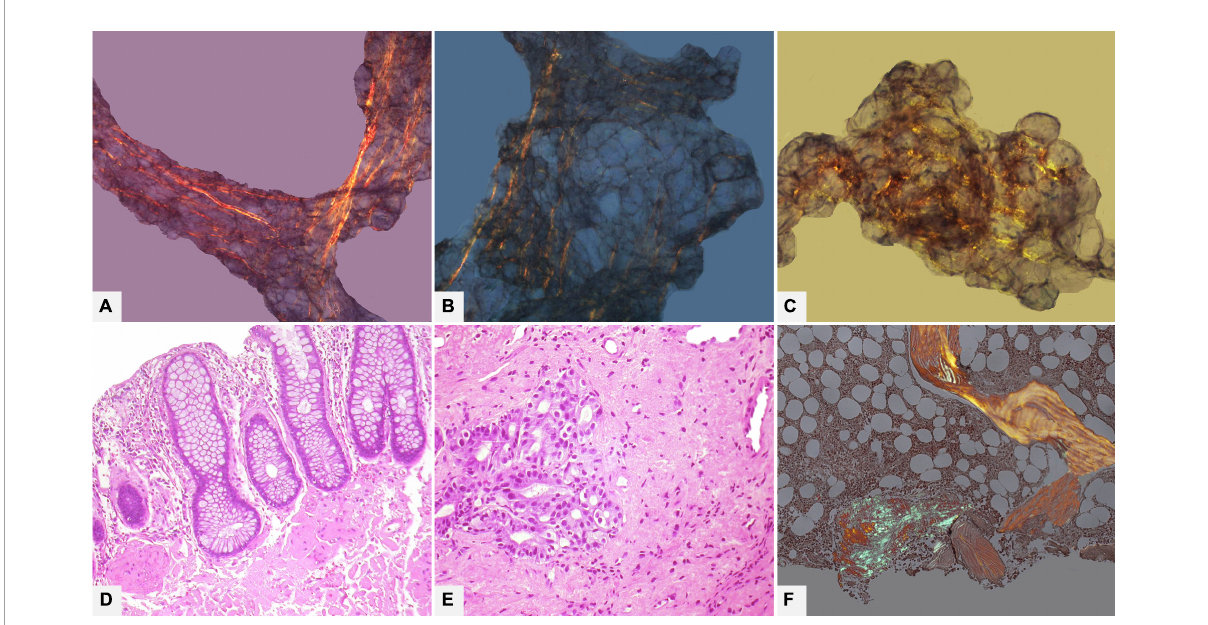
FIGURE10 Various tissue and organ biopsies of various patients with AL systemic amyloidosis. (A–C) (100 × ): Subcutaneous abdominal fat biopsy showing ambiguous birefringence, yellow and focally green, with Congo red under polarized light. (D) Rectal biopsy with mucosal and submucosal amyloid deposits (Hematoxylin-Eosin 200 × ). (E) Gastric biopsy with extensive submucosal amyloid deposits (Hematoxylin-Eosin 200 × ). (F) Bone marrow biopsy with interstitial nodular amyloid deposit with congo red under polarized light (50 × ).